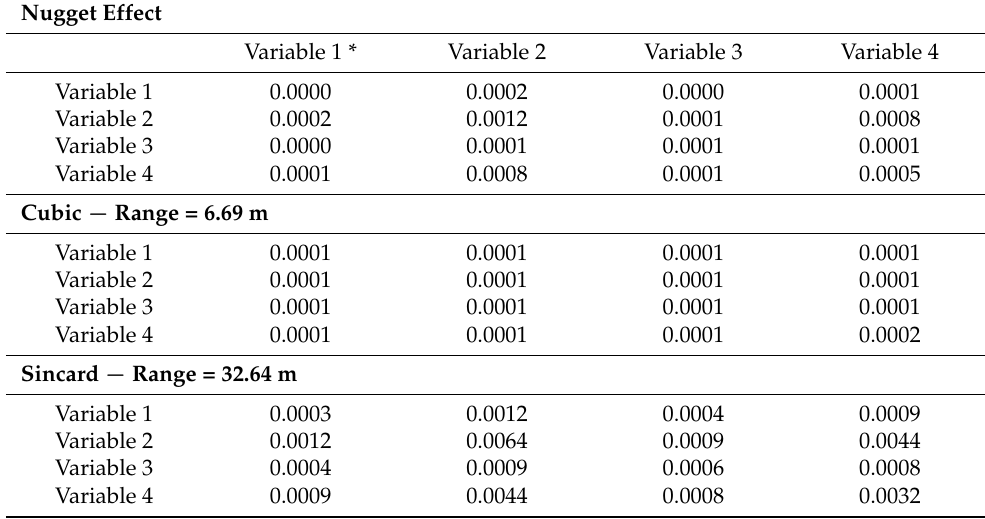
Table 1. Co-regionalization Matrix for each spatial